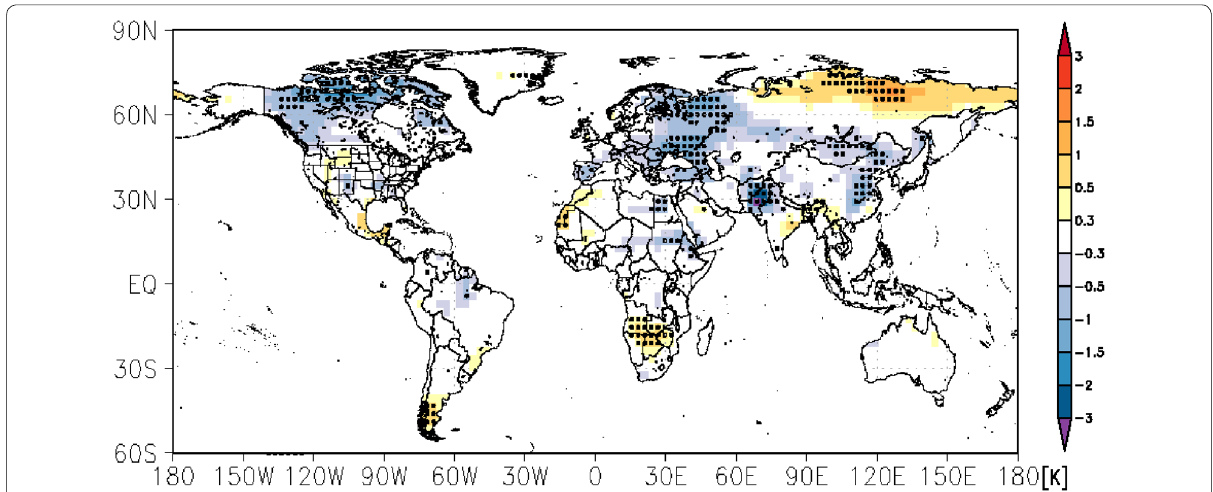
Fig. 6 Irrigation-induced changes in simulated 2 m air temperature, i.e., the difference between NAT-Online and HI-Online experiments. The dotted areas represent the grid cells that satisfy 95% statistical significance in Student’s t